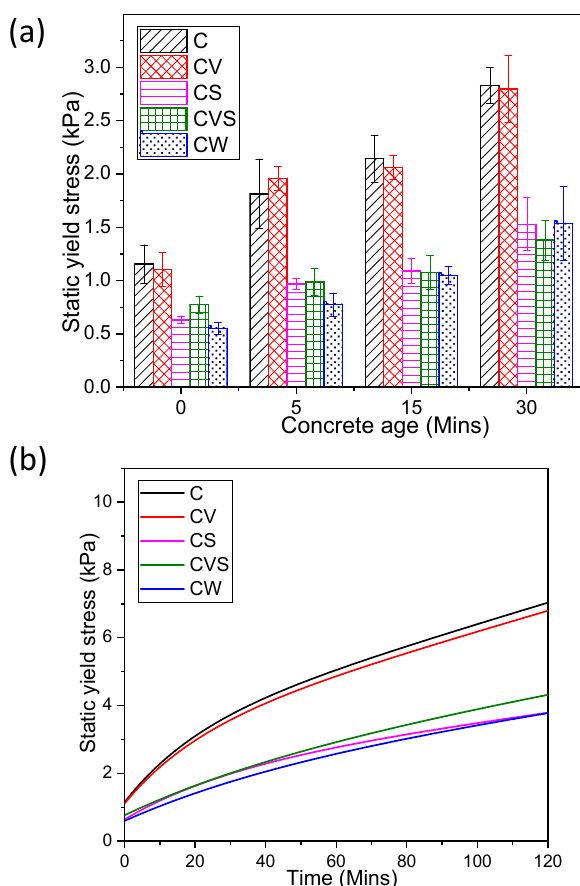
Figure 8. (a) Yield stress of the concrete mixes up to 30 minutes concrete age, and (b) the yield stress evolution. Rheo ‐ viscoelastic